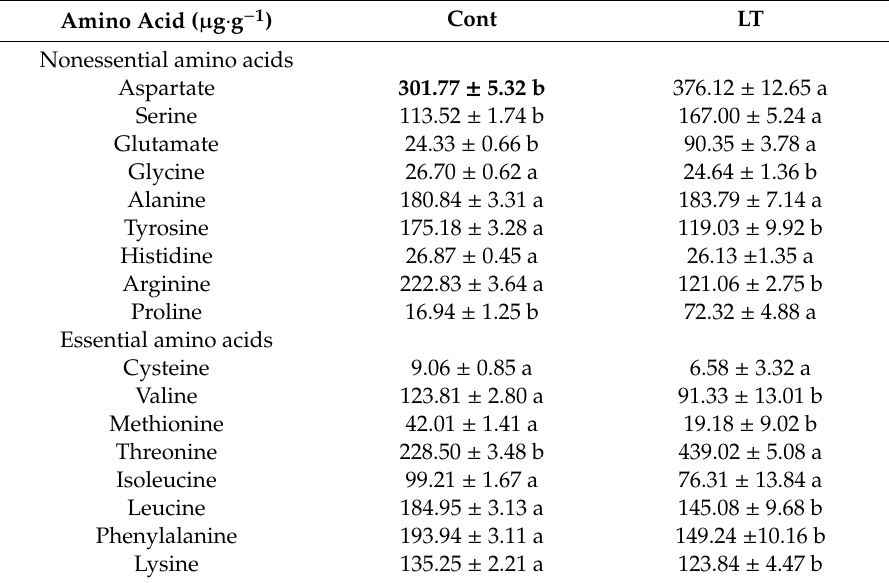
Table 2. Amino acid types and contents at Cont and